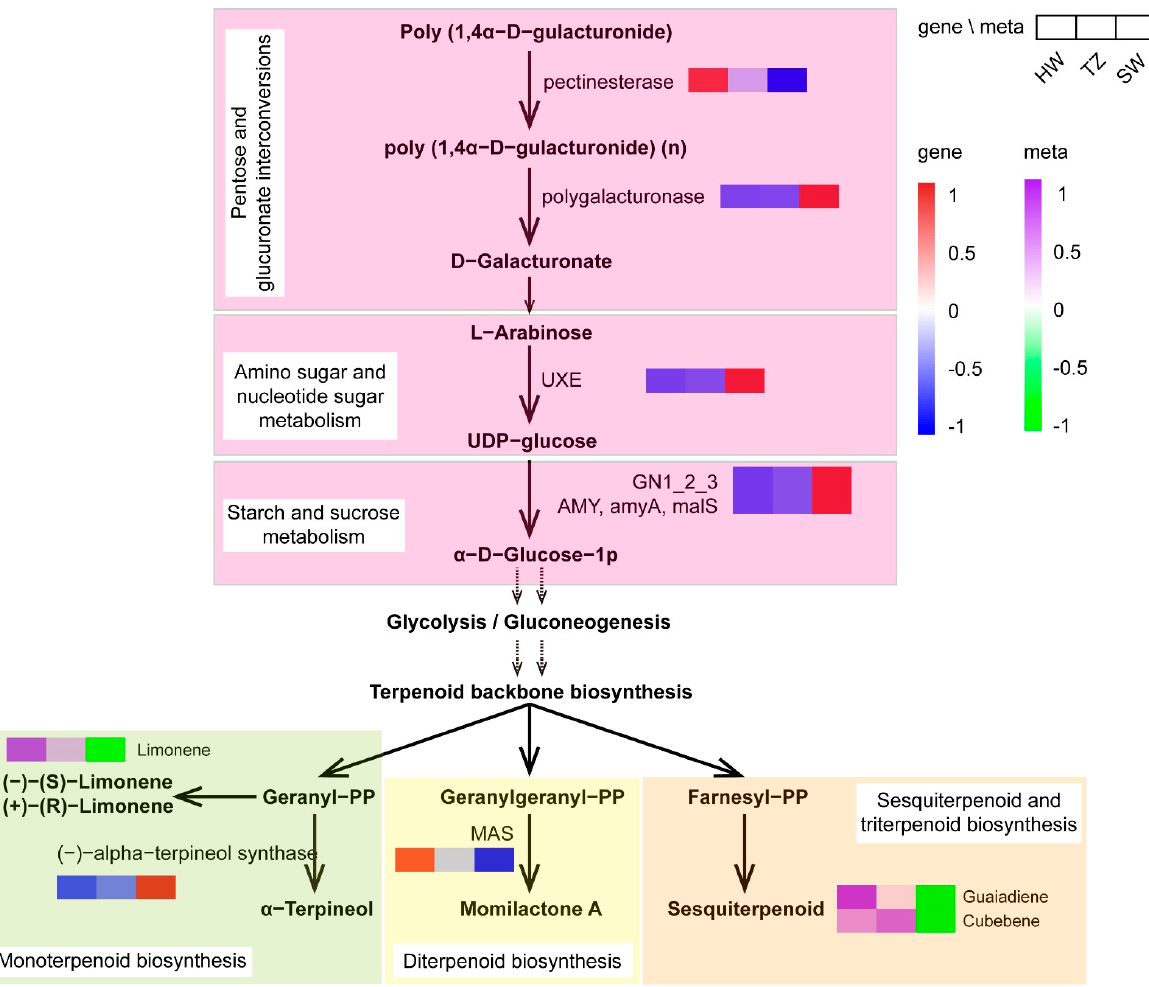
Figure 5. Schematic diagram of primary and secondary metabolism pathways (terpenoid biosyn- thesis) activated in the HW. The pathways with pink boxes represent the primary metabolic pathway. UXE: UDP-arabinose 4-epimerase. GN1_2_3: glucan endo-1,3-beta-glucosidase 1/2/3, AMY, amyA. malS: alpha-amylase. MAS: momilactone-A synthase.